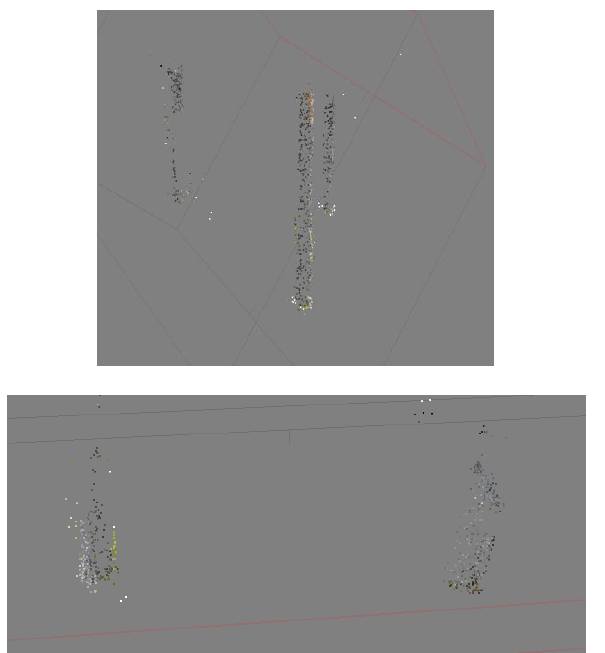
Figure 6: Point clouds generated by the PhotoScan software using a sequence of nine images from the (a) right and (b) left